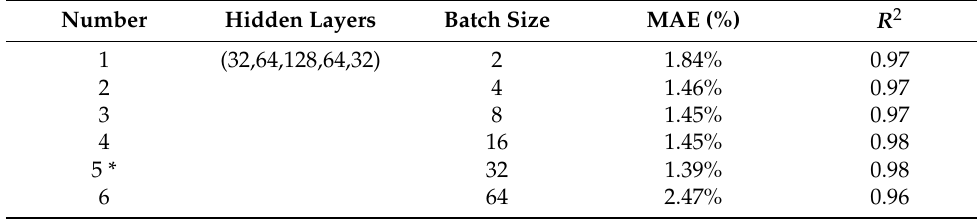
Table 4. The effect of batch size on the results.